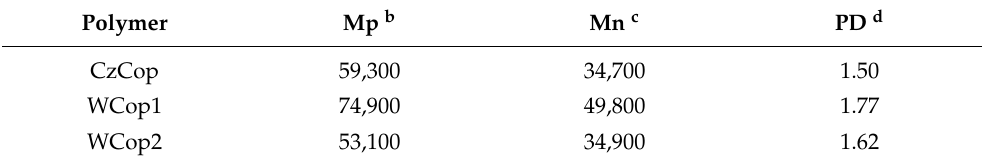
Table 2. Data obtained from Gel Permeation Chromatography (GPC) a of the synthesized polymers.